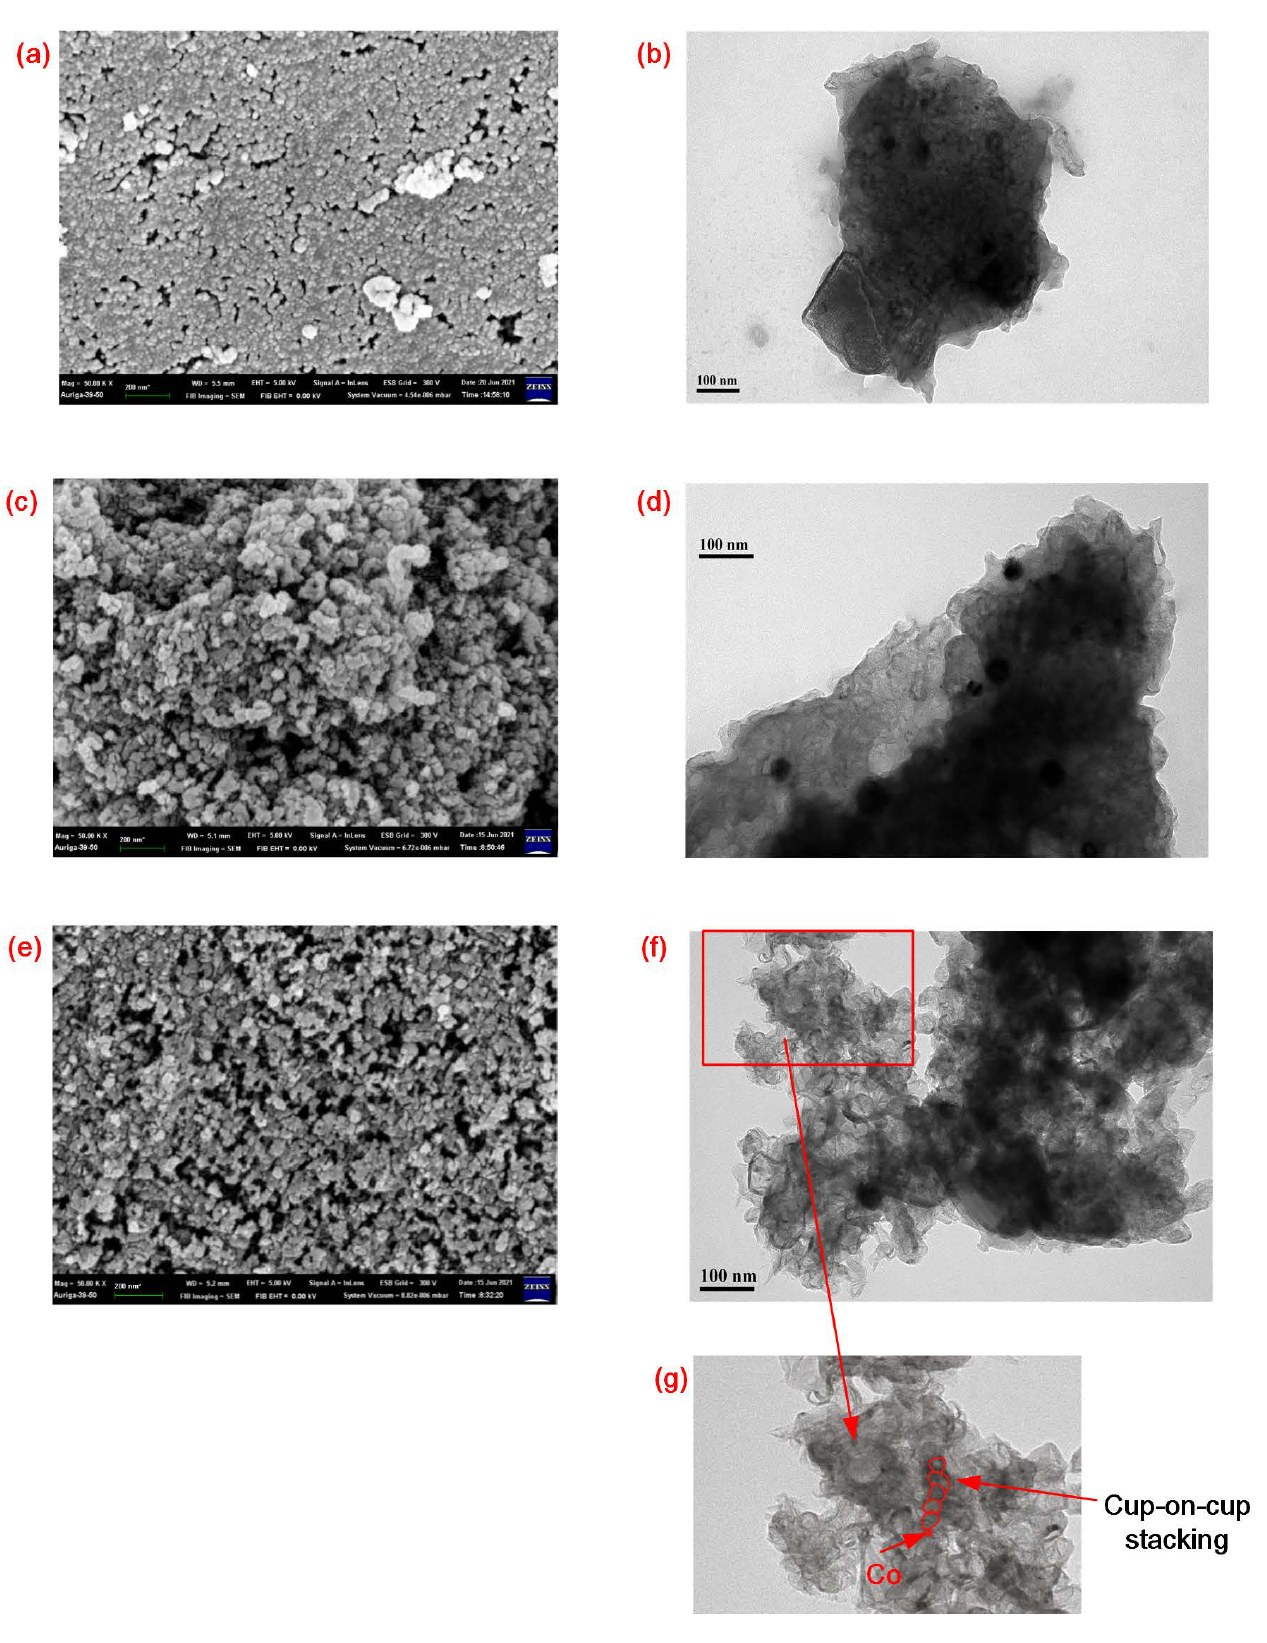
Figure 4. SEM and TEM micrographs of various CoNCs treated with two-stage calcinations, respec- tively, ( a , b ) of 800A-700; ( c , d ) of 900A-800; ( e , f , g ) of